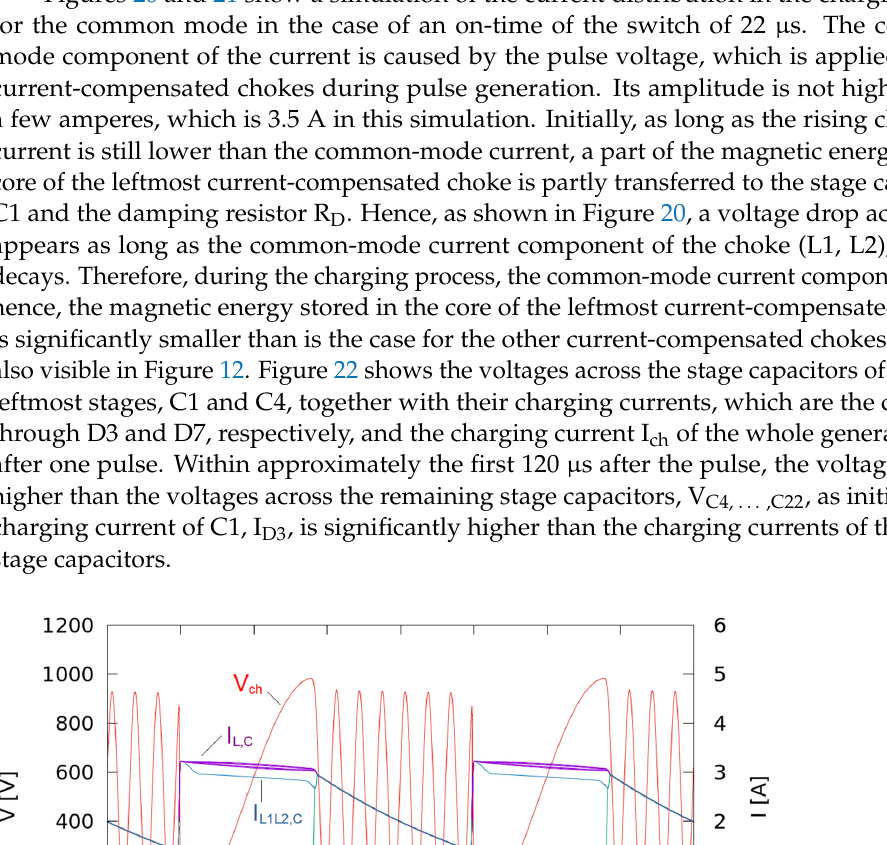
Figure 19. Distribution of the charging current along the charging path according to the position in the generator for an on-time of the solid-state switches of 200 µs. The notation is equal to Figure 18.